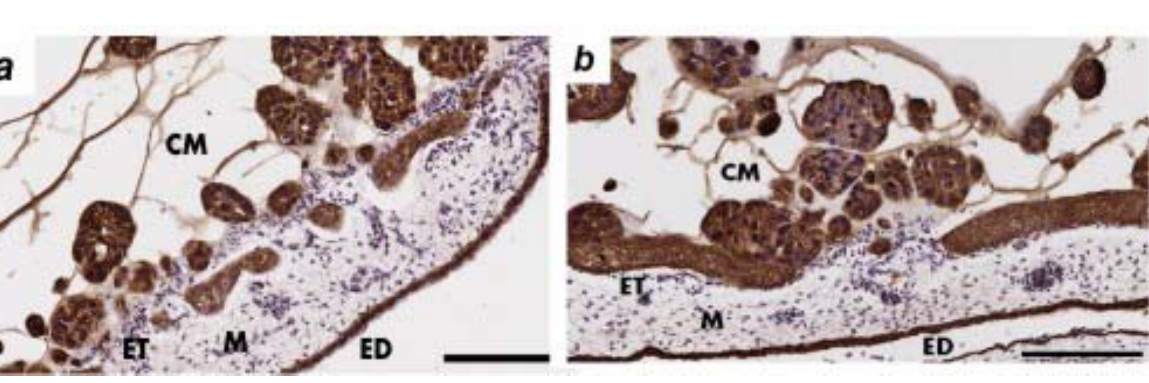
Figure 5. Effects of protein A neutralizing antibody on OV-90 cancer cell invasion into the chick chorioallantoic membrane (CAM). OV-90 cancer cells were mixed with matrigel and ( a ) control anti-mouse IgG (20 µg/mL); or ( b ) neutralizing antibody against protein A (20 µg/mL). CAM paraffin sections (6 µm) were immunostained with a pan-cytokeratin antibody. ET = ectoderm. M = mesoderm. ED = endoderm. CM = cancer cell matrigel grafts. Original magnification ×200, scale bar 100